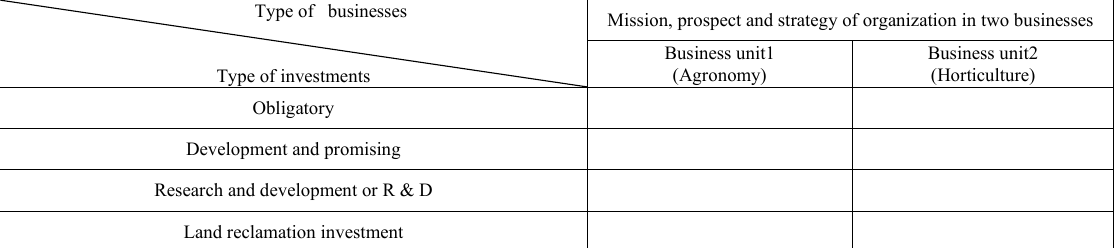
Suggested category for projects as case study in agriculture